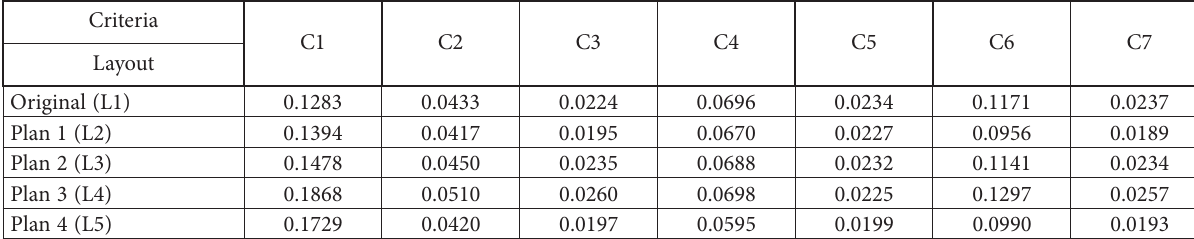
Table 12. Weighted decision